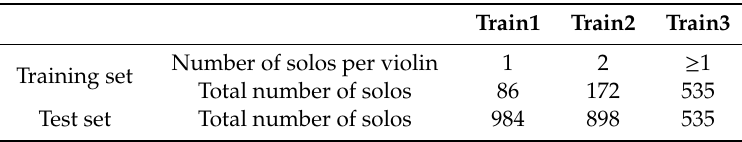
Table 2. Data partition of the training and test sets. Train1 Train2 Train3 Number of solos per violin 1 2 ≥ 1 Training set Total number of solos 86 172 535 Test set Total number of solos 984 898